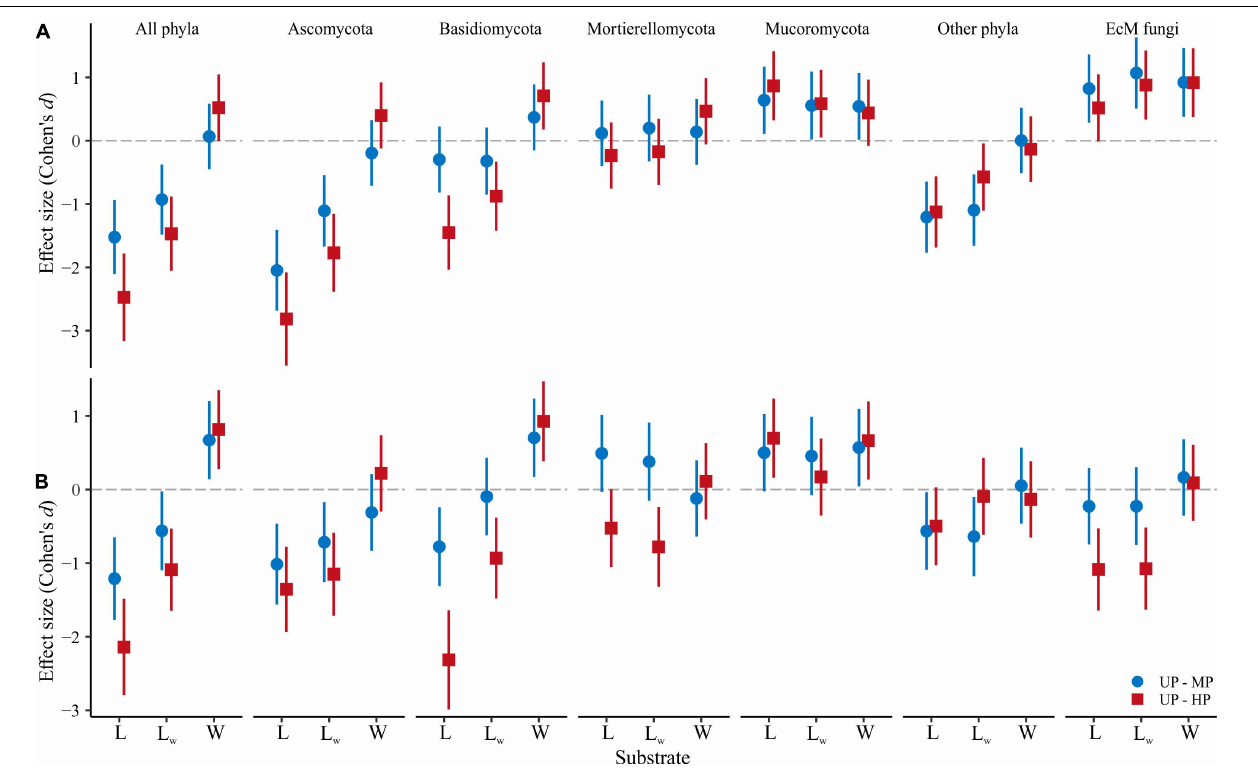
FIGURE 3 | Pollution-induced changes in (A) OTU richness and (B) effective number of OTUs in MP (circles) and HP area (squares) within three types of forest detritus (L, CWD-uninfluenced litter CWD; L W , CWD-influenced litter; W, wood). The negative effect size indicates a pollution-induced decrease of fungal diversity compared with the UP area, positive effect size – diversity increase. Median and 95% CI are shown. OTU, operational taxonomic unit; MP, moderately polluted; HP, heavily polluted; CWD, coarse woody debris; UP,